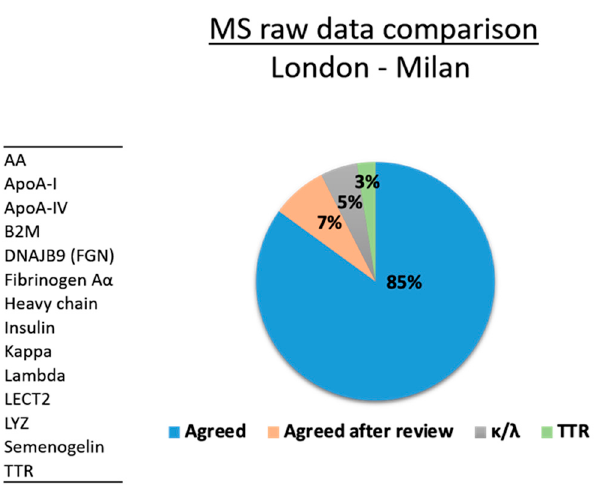
Figure 1. Mass Spectrometry (MS) raw data comparison between London (NAC) and Milan (ITB- CNR) proteomics platforms.